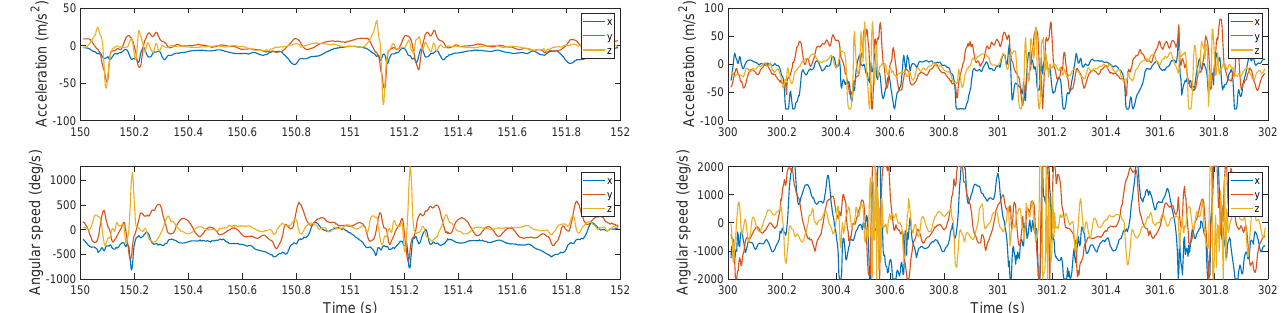
Figure 2. Example of the recorded IMU signals from the Foot IMU sensor for the first subject for walking speed of 6.5 km/h ( left ) and running speed of 24.2 km/h ( right